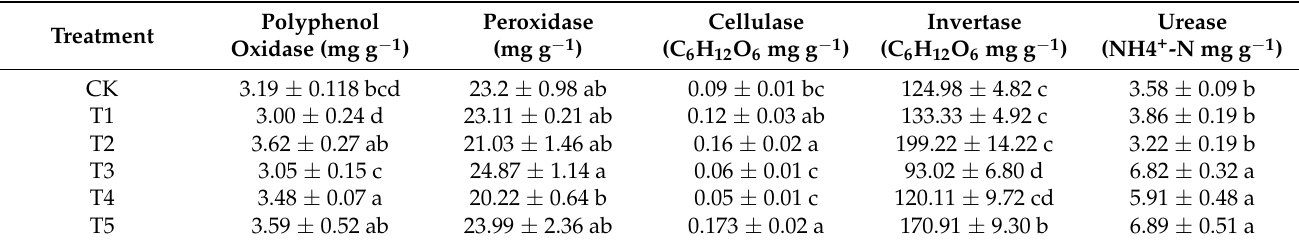
Table 1. Effects of different treatments on enzyme activities. The values are means ± SE ( n = 3). CK: no biochar and no N addition; T1: 0.64% biochar + 0% NH 4 NO 3 ; T2: 1.28% biochar + 0% NH 4 NO 3 ;